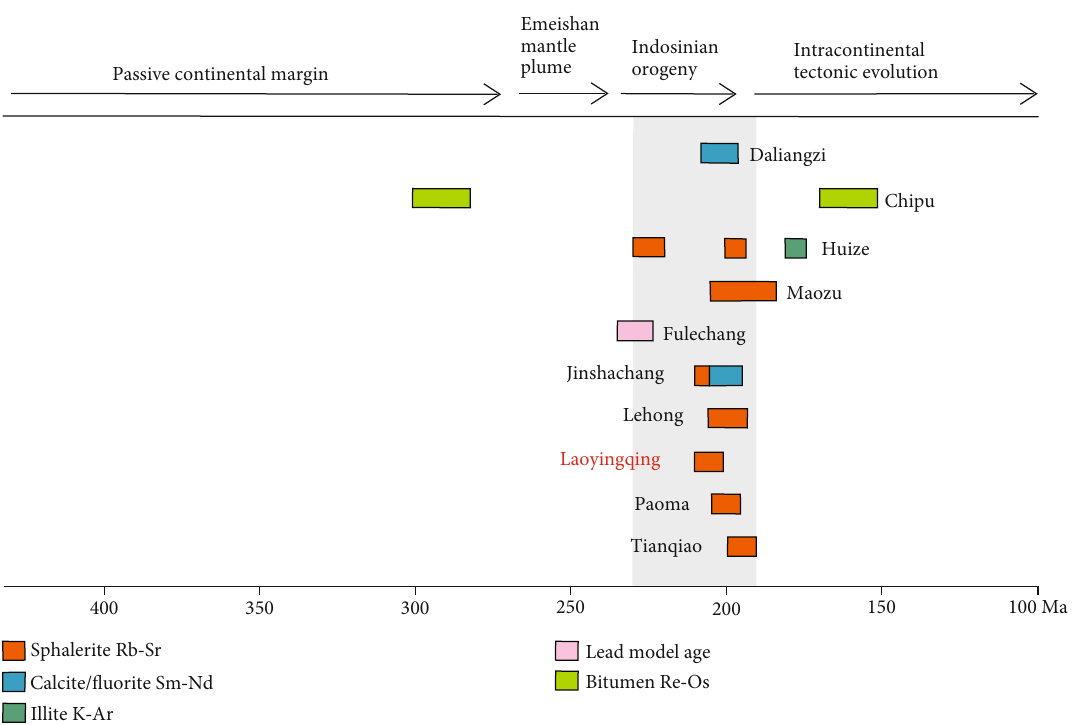
Figure 8: Ages and geological settings of major Pb – Zn deposits in the SYGT (modi fi ed from [91]). Sources of the data are taken from Yin et al. [53], Lin et al. [89], Wu [13], Zhou et al. [12], Zhang et al. [14], Zhang et al. [7], Zhou et al. [80], and this